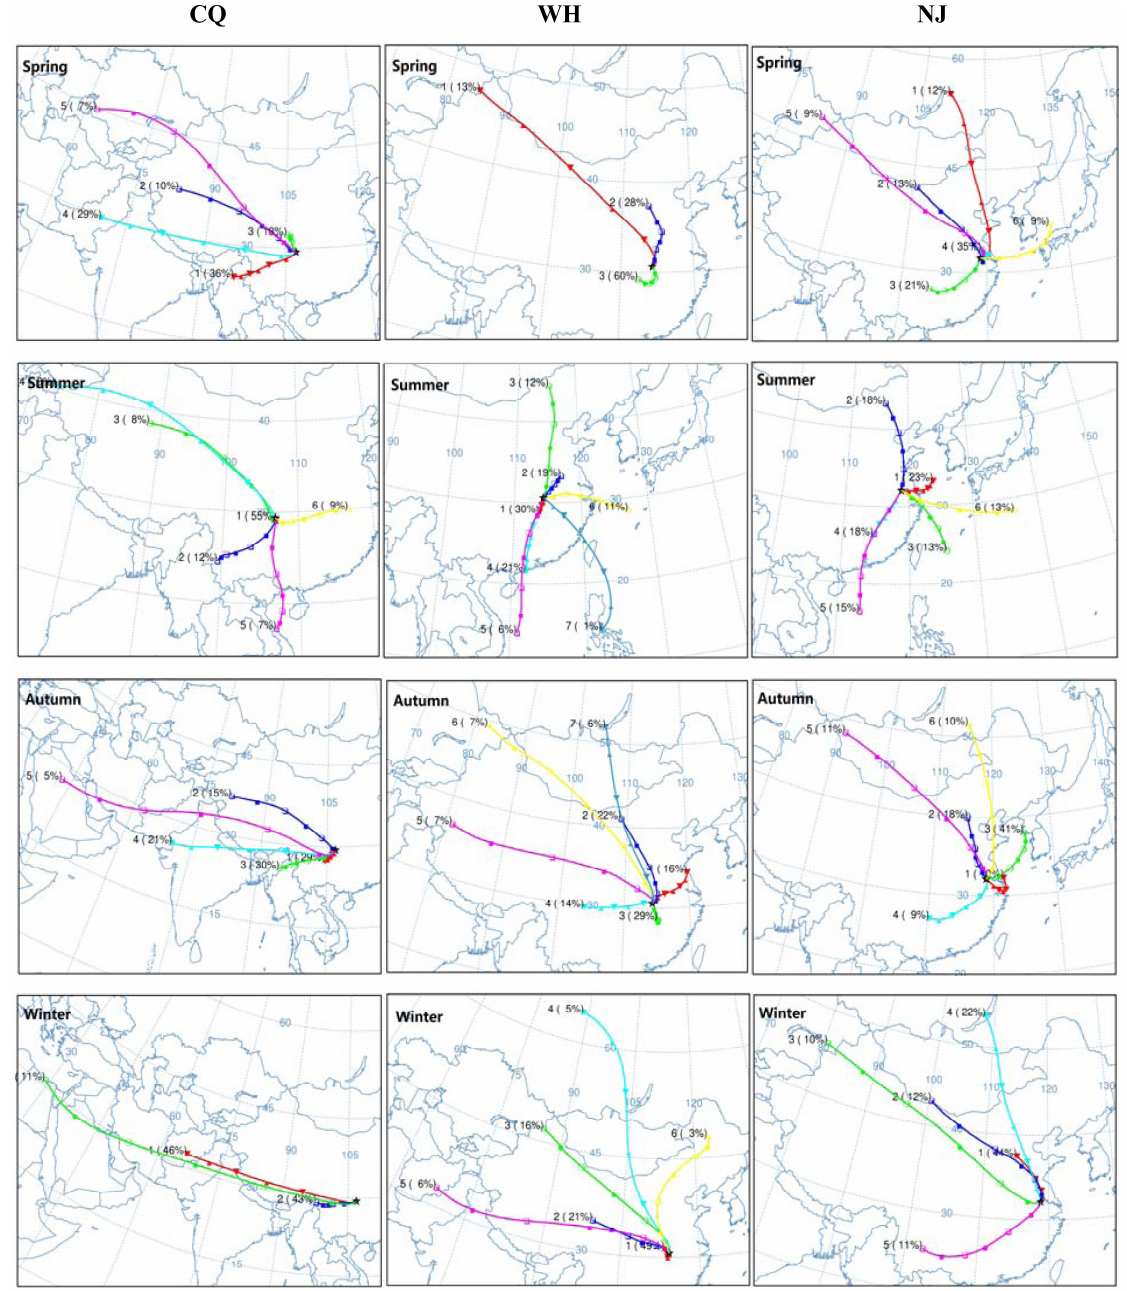
Figure 8. 72 h airmass backward trajectories analysis for seasonal distribution in Chongqing, Wuhan, and Nanjing using hierarchical clustering method.